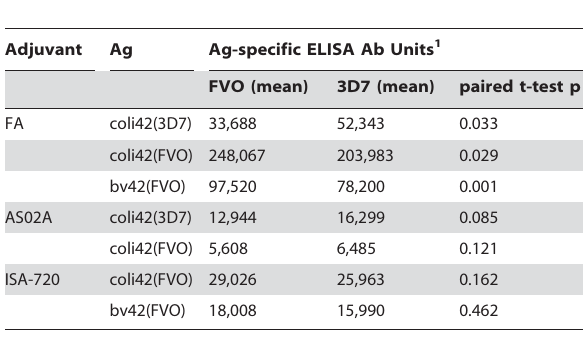
Table 4. Group Wise Comparisons of Adjuvant Effect on Induction of Strain-specific Ab